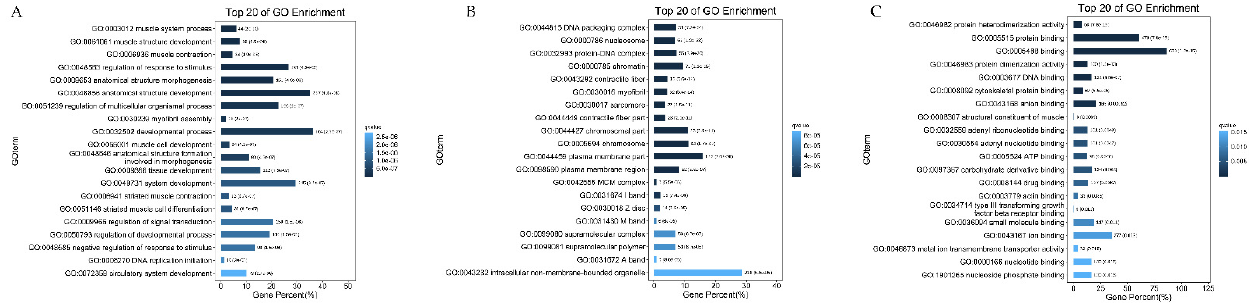
Figure 5. GO enrichment analysis of DM1 vs. DM5. ( A ) The top 20 significance terms of Biological Process in DM1 vs. DM5; ( B ) the top 20 significance terms of Cellular Component in DM1 vs. DM5; ( C ) the top 20 significance terms of Molecular Function in DM1 vs. DM5 .